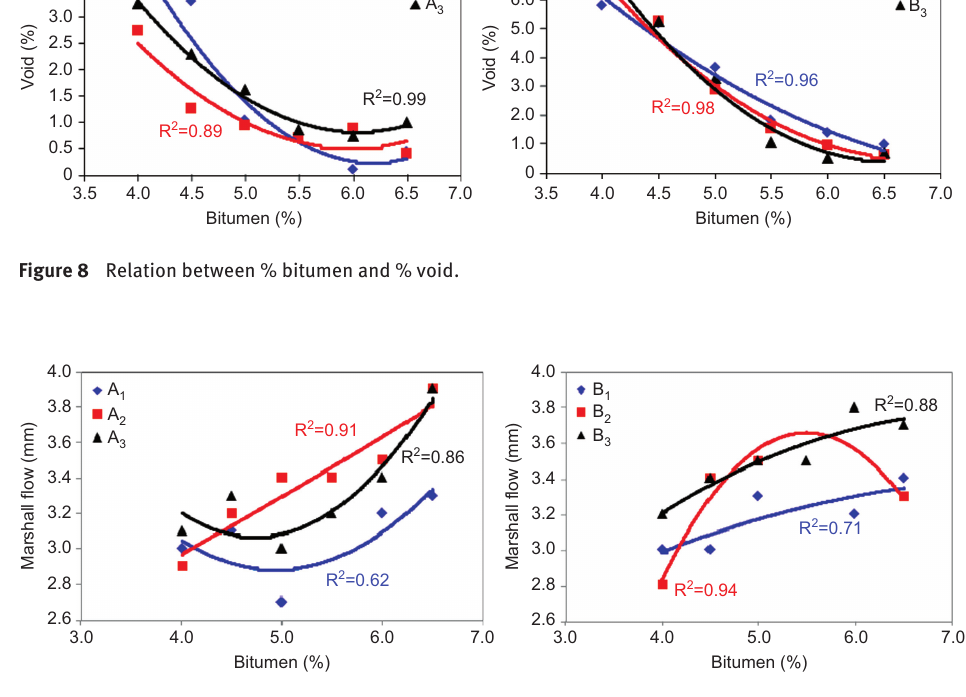
Figure 9 Relation between % bitumen and % Marshall